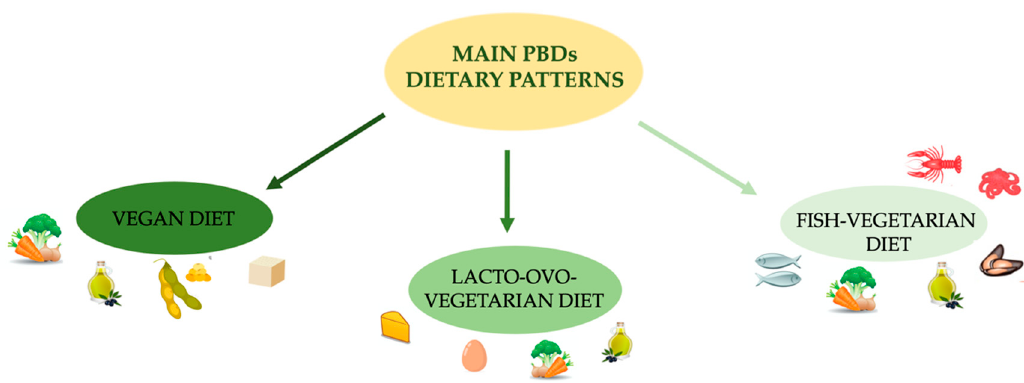
Figure 1. Main PBD dietary patterns. Abbreviation: PBDs, plant-based diets.